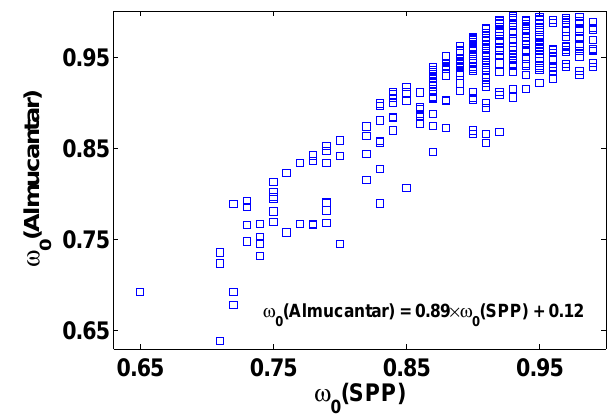
Fig. 2. ω 0 values retrieved from measurements in almucantar (AERONET) mode versus ω 0 extracted from SPP measurements (our technique), IASBS site, February 2010 to December